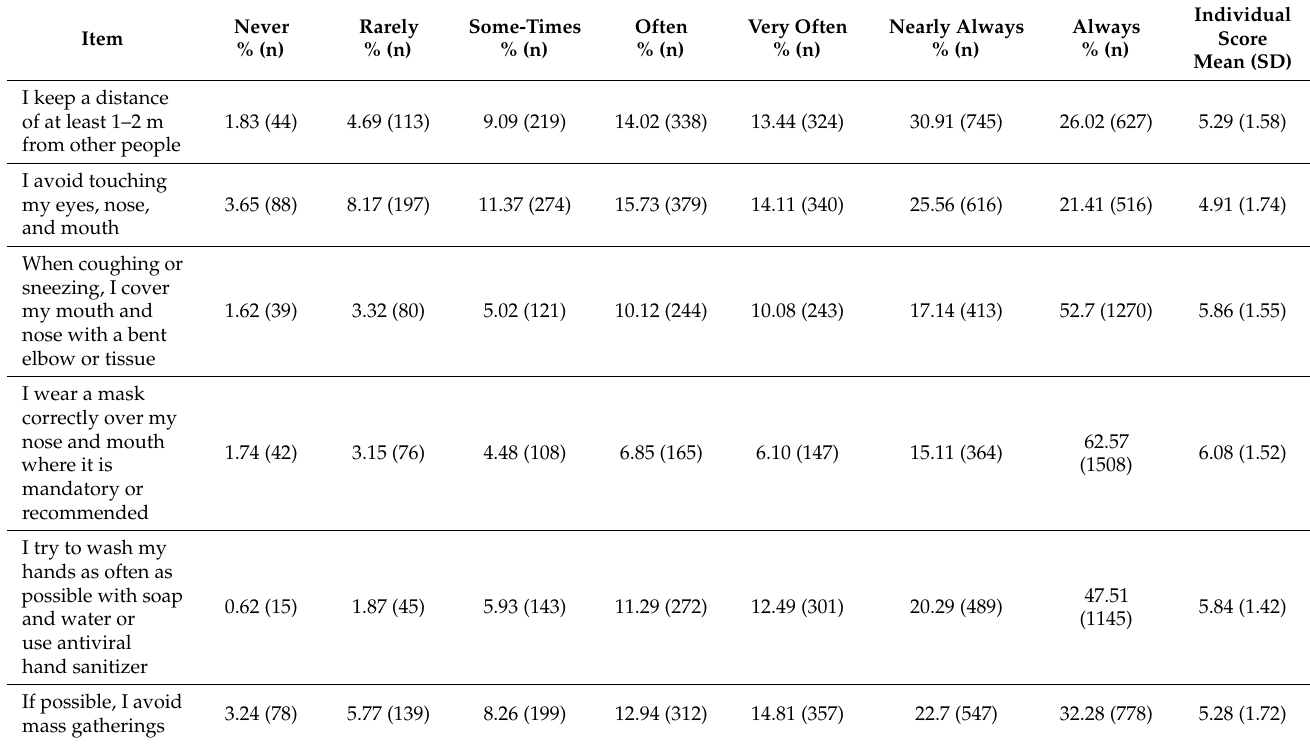
Table 3. Distribution of responses to items asking about adherence to COVID-19 preventive